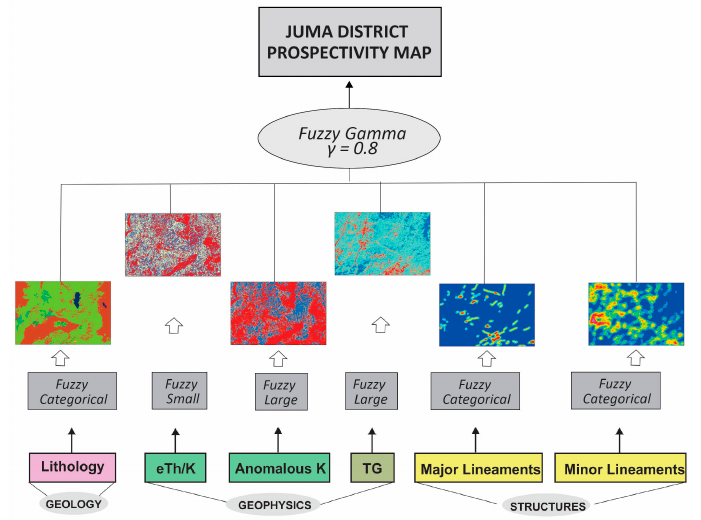
Figure 5. Flowchart detailing the main steps for Juma District prospectivity modeling, including the fuzzy logic operators and pertinence functions.